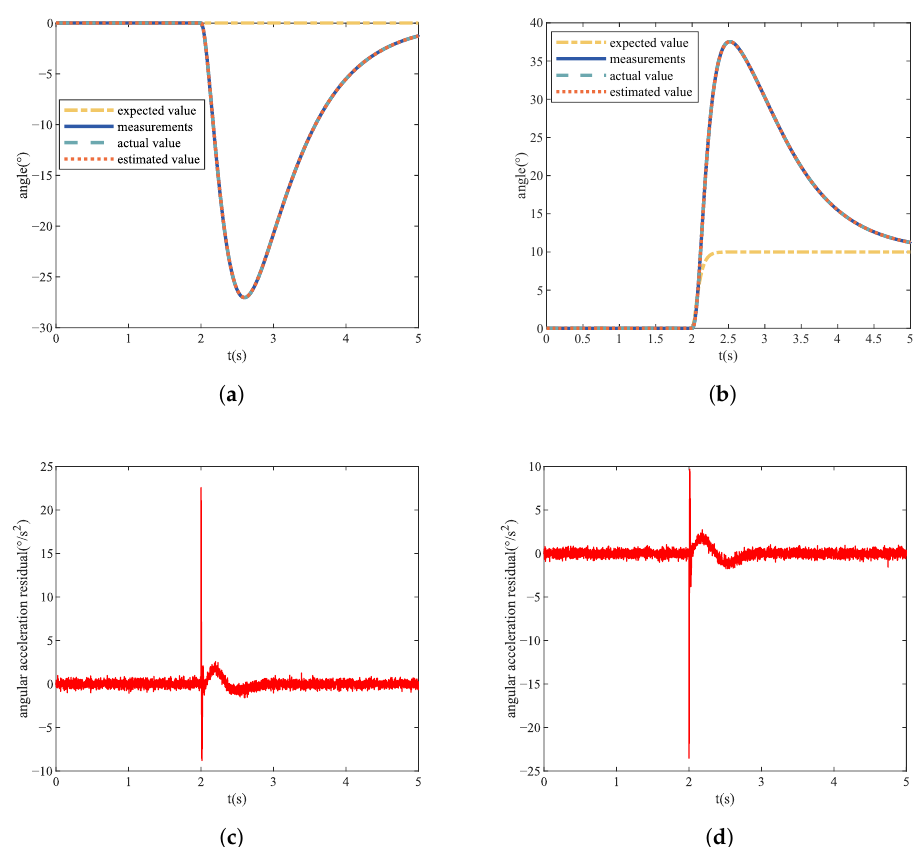
Figure 7. No. 1 actuator gain loss fault. ( a ) Pitch angle signal value. ( b ) Roll angle signal value. ( c ) Pitch angular acceleration residual signal. ( d ) Roll angular acceleration residual